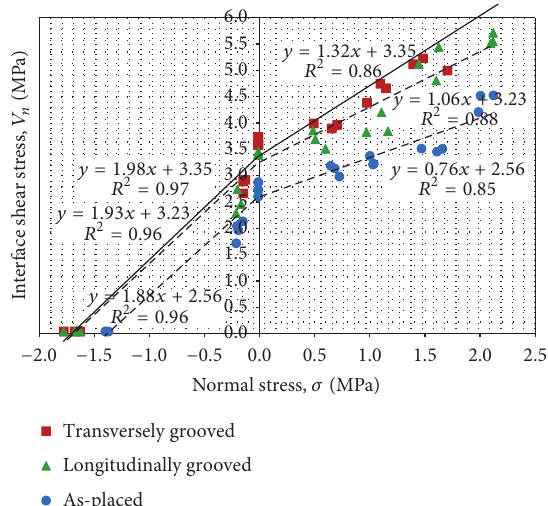
Figure 9: Effect of different normal (compression and tension) stressonthebondstrengthofinterfacebetweenlightweightconcrete substrate and SCC